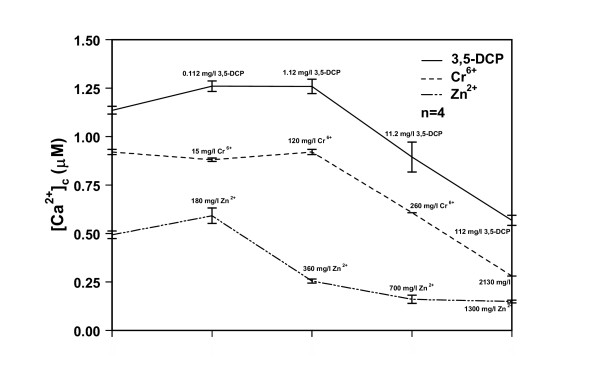
Effect of 3,5-DCP, Cr6+ and Zn2+ on amplitude of [Ca2+]c in A. awamori 5 minute incubation.